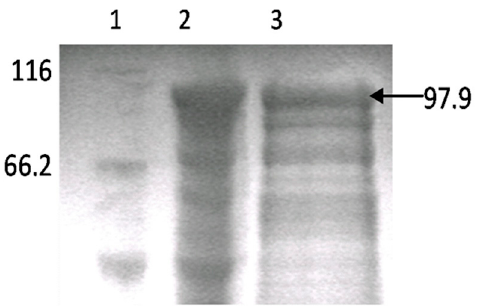
Figure 1. Expression of recombinant PKR protein in E. coli and its purification. 1. Protein marker; 2. pET32-PKR induced with IPTG; 3. Purified, recombinant PKR of a size of 97.9 kD.